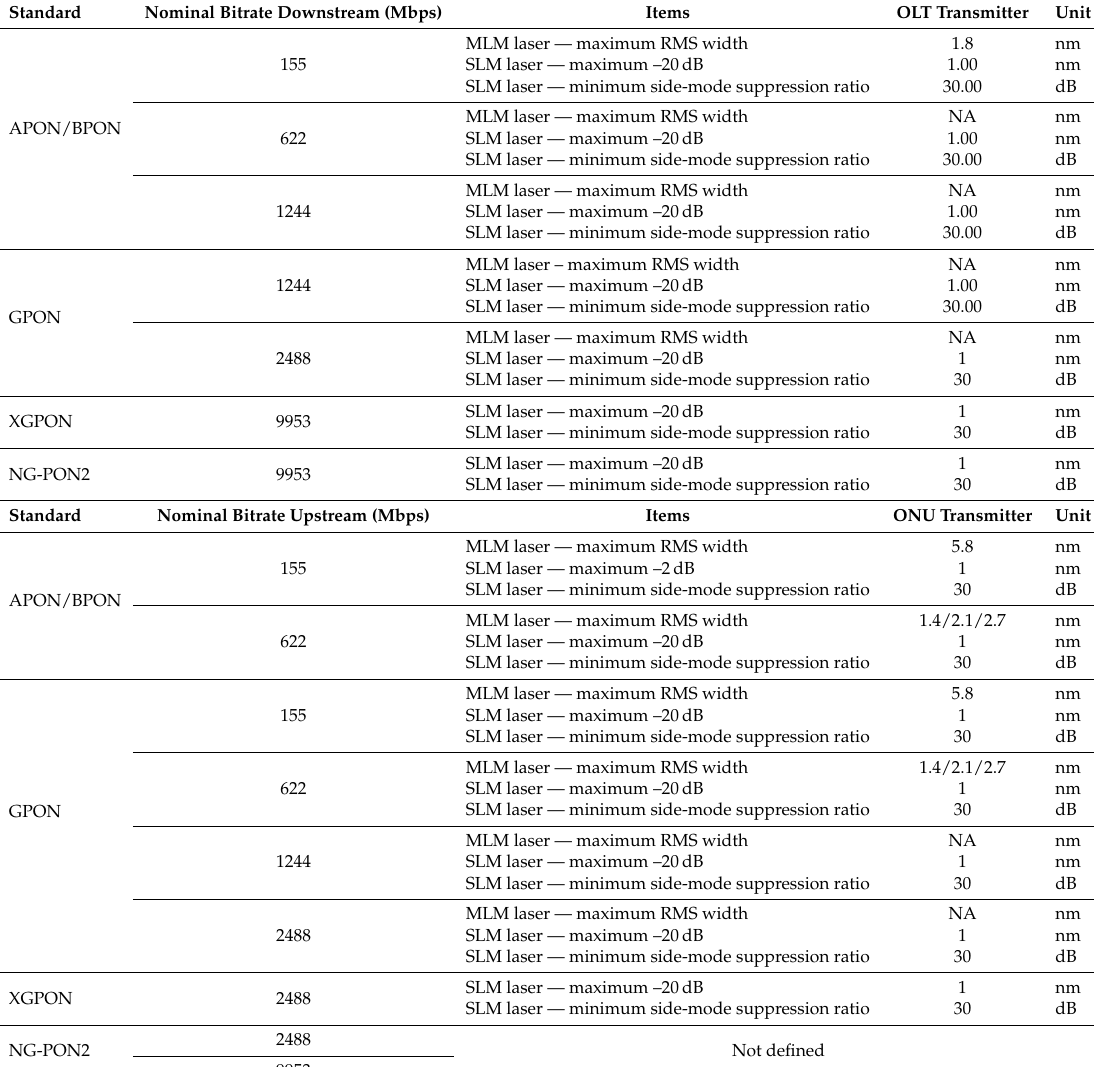
Table 3. ITU-T laser requirements for PONs